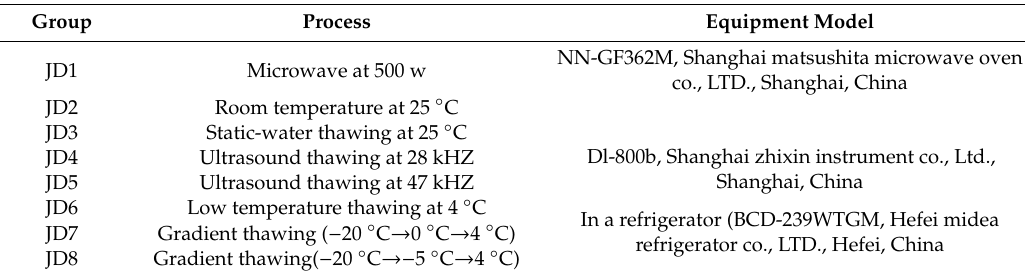
Table 1. Di ff erent thawing